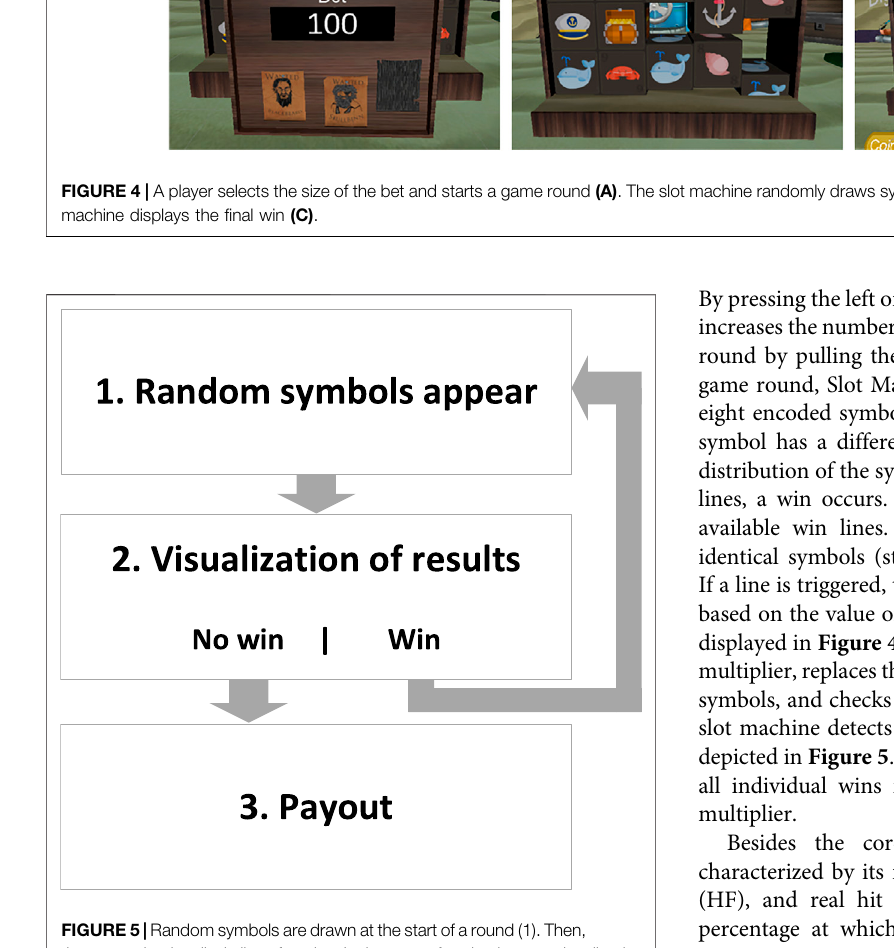
Frontiers in Virtual Reality |